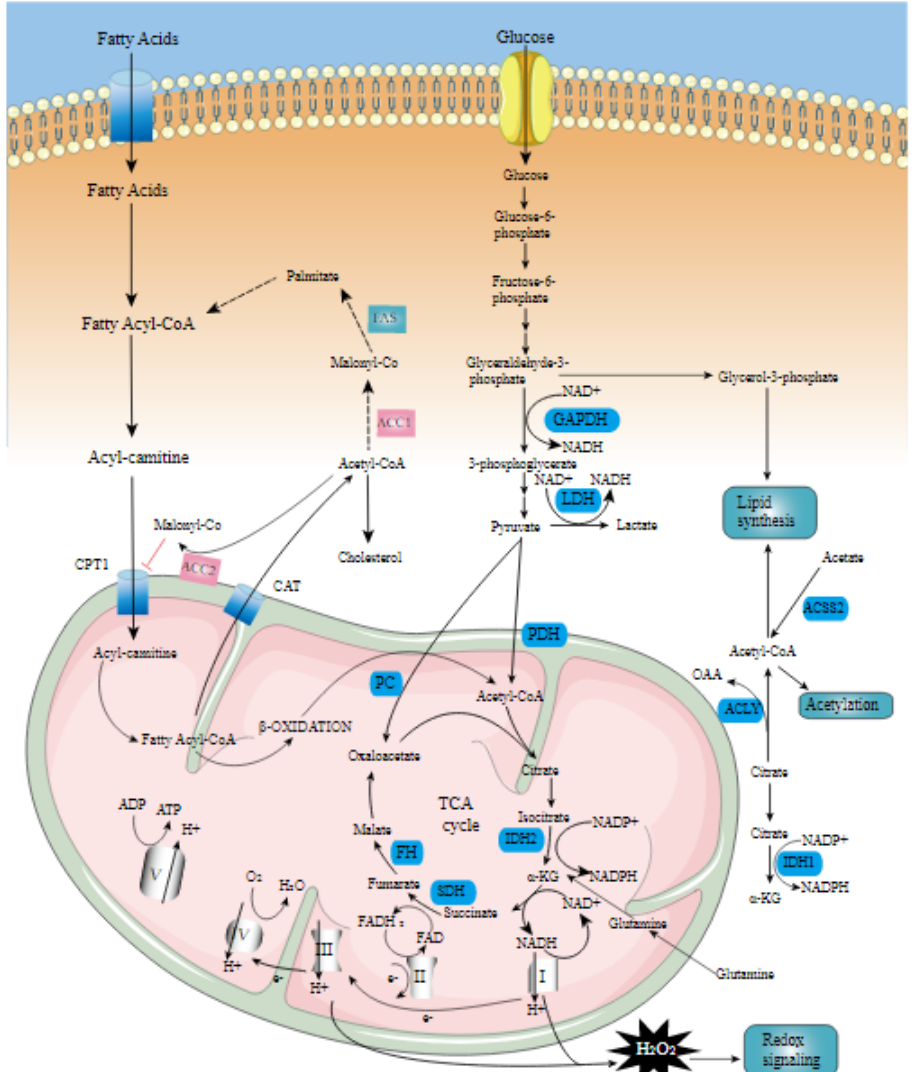
Figure 1. Lipid metabolism signaling pathway ( https://www.creative−diagnostics.com/lipid−me- tabolism−signaling−pathway.htm; accessed on 12 November 2022 ). Lipid metabolism mainly